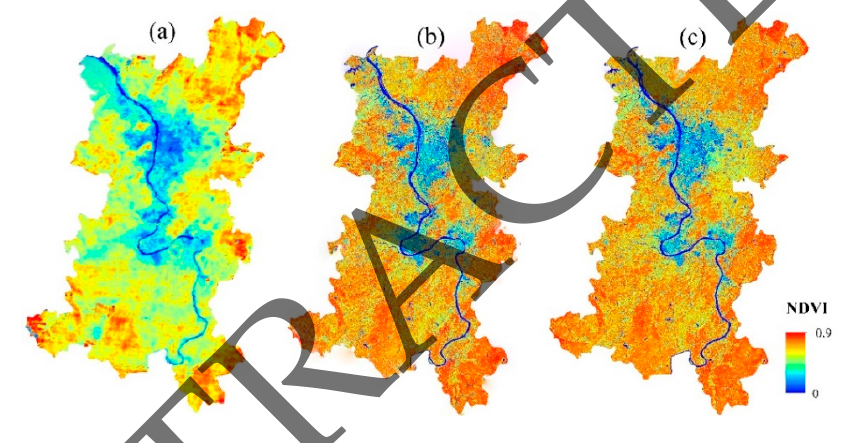
Figure 6. ( a ) The MODIS NDVI of DOY 257, ( b ) the fused NDVI generated by the ESTARFM model of DOY 257, and ( c ) the actual Landsat8 OLI NDVI of DOY 260.